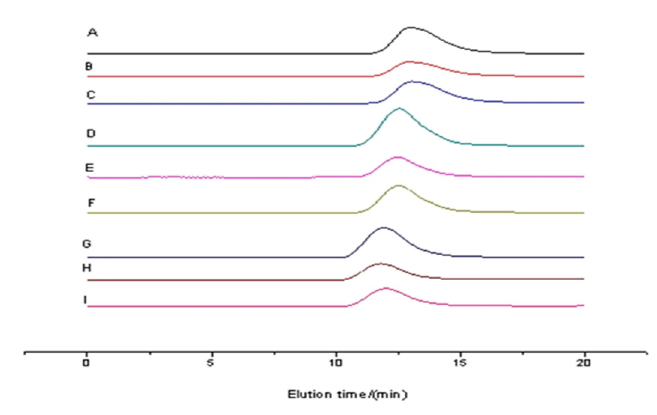
Figure 7. Gel permeation chromatography (GPC) curves of copolymers. Table 3. Molecular weights of copolymers.